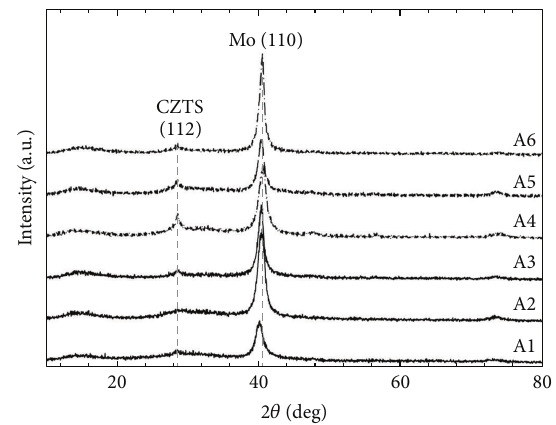
Figure 1: Temperature profile for annealing treatment.